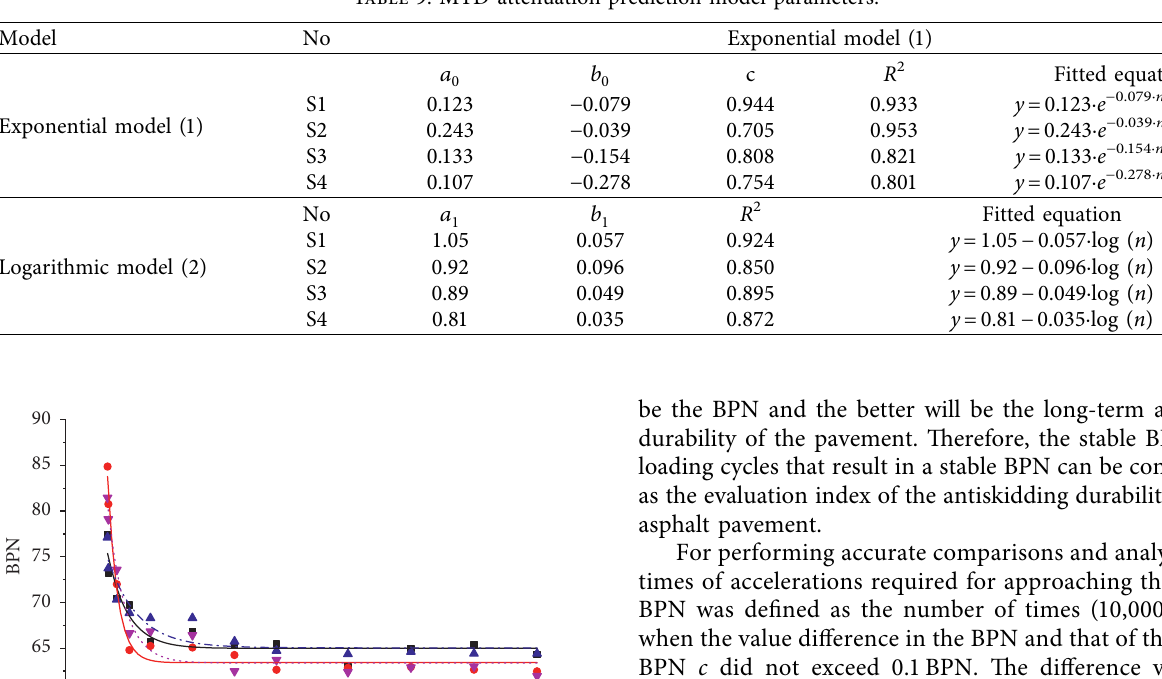
Table 9: MTD attenuation prediction model parameters.